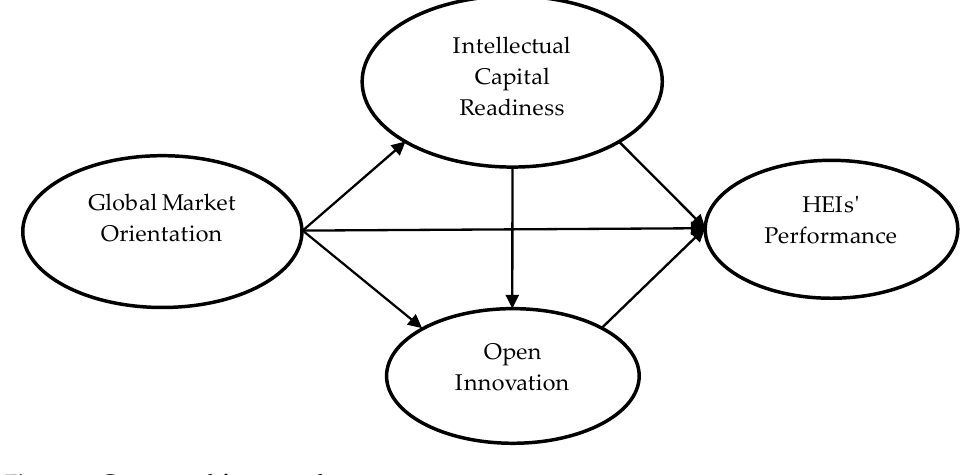
Figure 1. Conceptual framework.